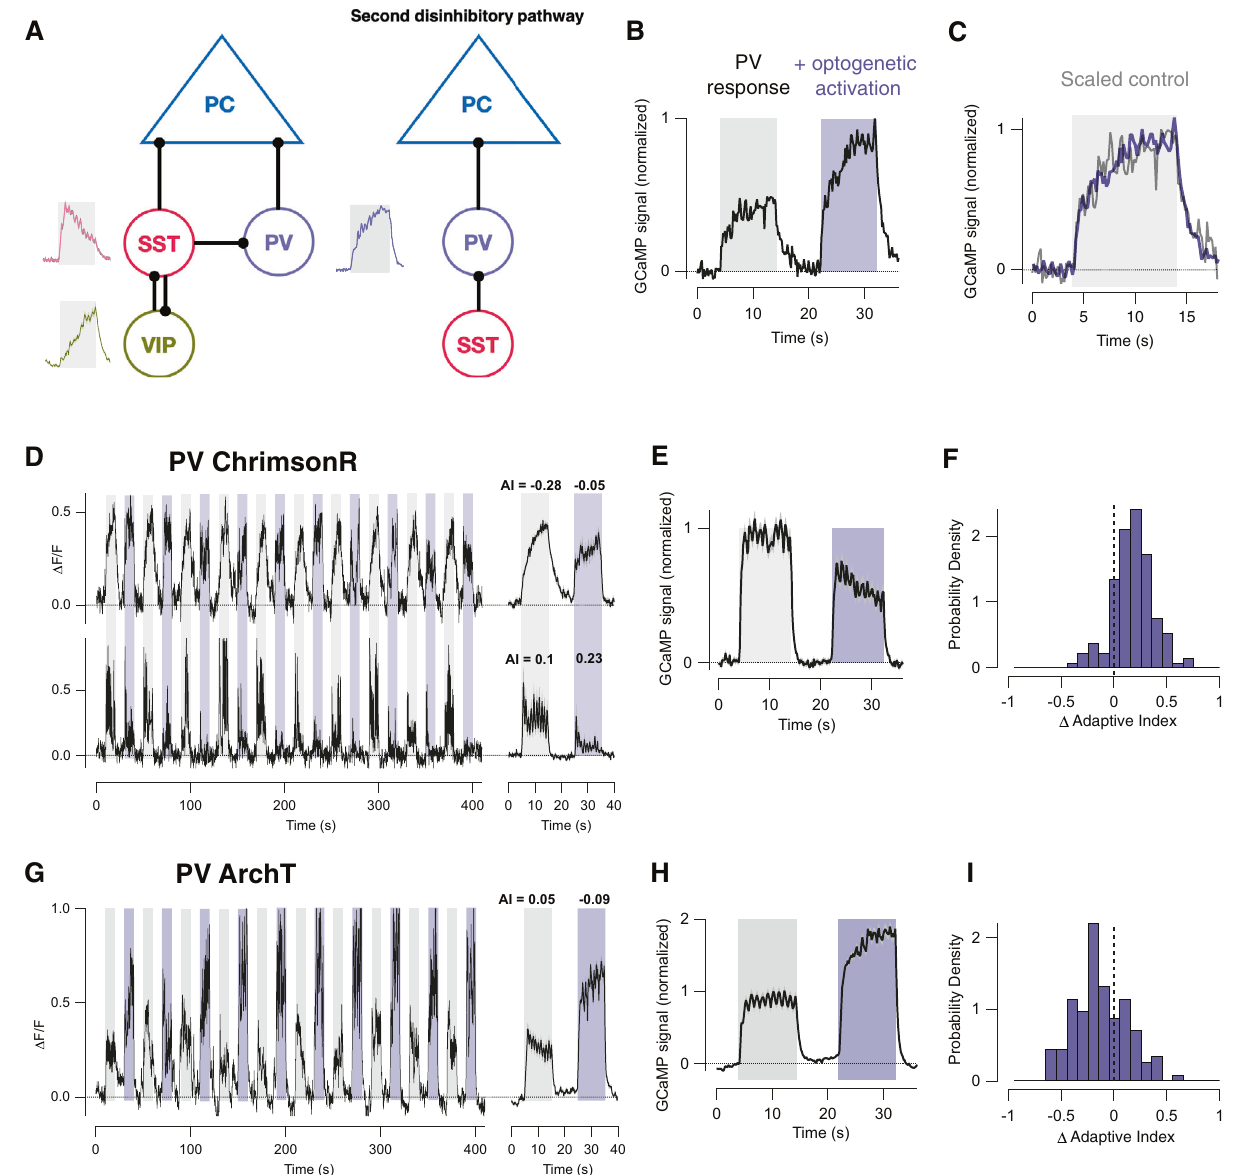
Fig. 4 PV interneurons drive depressing adaptation in pyramidal cells. A Schematic of major inhibitory connections in layer 2/3 of V1. Left: major direct inputs to PCs are from SST and PV interneurons. VIP → SST pathway disinhibits PCs. Right: A second disinhibitory pathway from SST → PV. Average response trace from Fig. 3 also shown. B Population average of GCaMP6f signal in PV cells in response to the visual stimulus delivered without (grey bar) and with (purple bar) optogenetic activation using ChrimsonR (89 cells, two mice). C Control response (grey) scaled by a factor of 1.79 demonstrating the same time- course as the response during activation of ChrimsonR (purple). D An example of the responses of PCs when optogenetically activating PV interneurons. Left: average responses from two fi elds of view recorded from the same mouse on the same day (top, 18 cells; bottom, 6 cells). Right: average response from these trials. Top: AI = − 0.28±0.03 in control conditions and − 0.05±0.03 during PV activation (difference signi fi cant at p = 0.002, WSR test). Bottom: AI = 0.13±0.04 in control conditions and 0.21±0.07 during PV activation (no signi fi cant difference, WSR test). E Average of paired stimulus trials from experiments shown in D ; n = 3 mice, 296 cells). Over-activation of PV cells reduced gain in PCs and pushed the population towards depressing adaptation. F Distribution of changes in AI caused by activation of PV cells expressing ChrimsonR. The distribution is shifted towards positive values (signi fi cant at p = 0.0001, WSR test). G An example of the response of PCs when optogenetically inhibiting PV interneurons with ArchT (purple bars). Average of 43 cells in one FOV. AI = 0.04±0.05 in control conditions and − 0.09±0.05 during PV inhibition (difference signi fi cant at p = 0.03; WSR test). H Average of paired stimulus trials from experiments shown in G ( n = 3 mice, 264 cells). I Distribution of changes in AI caused by inhibition of PV cells expressing ArchT. (signi fi cant at p = 0.002; WSR test). Data are represented as mean±SEM (grey shading area in B , E , H ) or probability density ( F , I ). Source data are provided as a Source Data fi two fi elds of view are shown in Fig. 4D, one which sensitized in response averaged over 296 PCs (Fig. 4E). The distribution of control conditions (top, AI = − 0.28, 18 PCs) and one that changes in AI caused by over-activation of PV cells is shown in displayed little adaptation (AI = 0.1; 6 PCs). Increasing PV Fig. 4F and is shifted towards positive values (signi fi cant at activity (purple bars) had two basic effects: the initial gain of the p < 10 − 4 , WSR test). Such changes in the AI of PCs caused by optogenetic activation of interneurons were not correlated with response was reduced and the AI increased, as can be seen in the